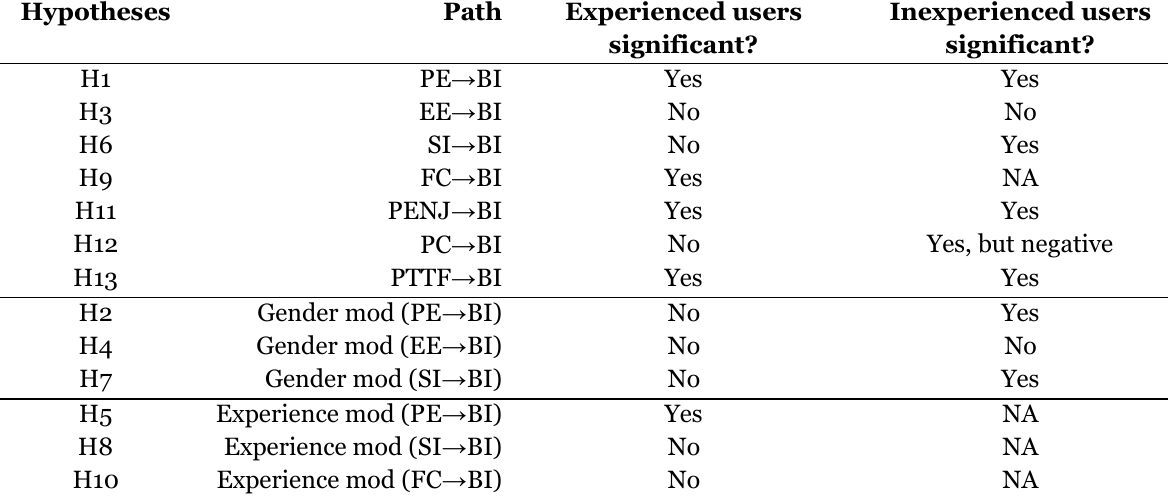
Results of Hypotheses